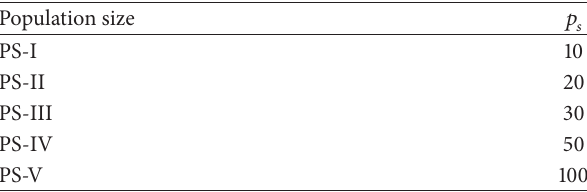
Table 9: Population size.